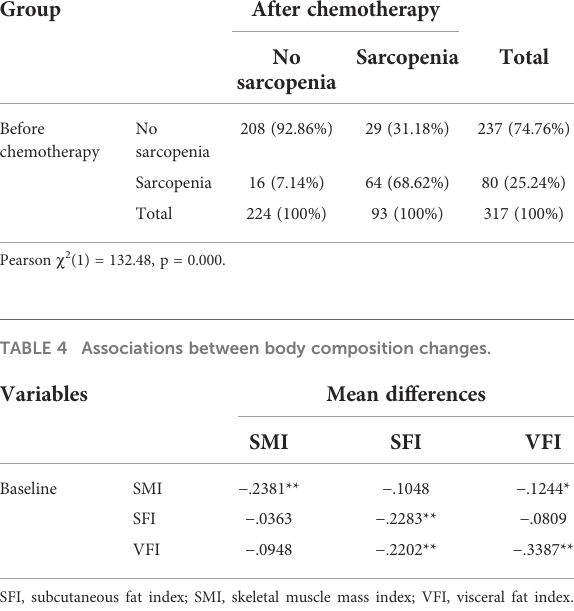
TABLE 5 Multivariate logistic regression analyses to predict sarcopenia after neoadjuvant